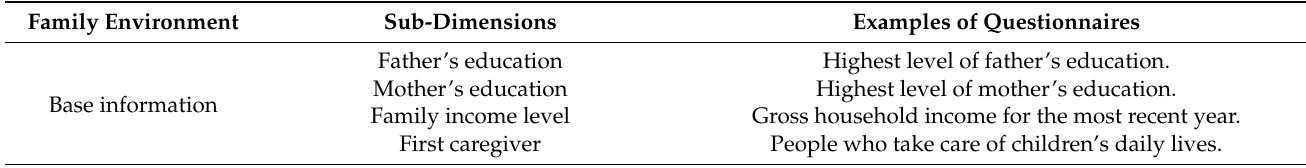
Table 1. Sub-dimensional factors of household environmental impact and questionnaire